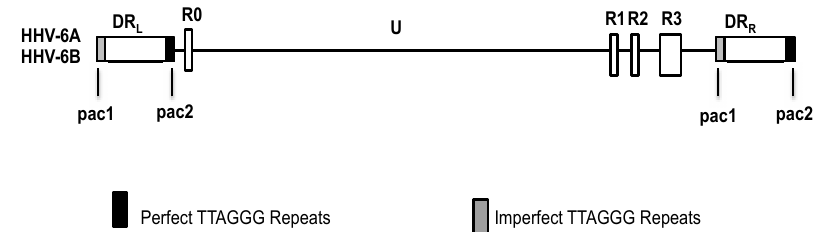
Figure 1. Genome organization of human herpesvirus-6 (HHV-6). Solid lines represent the unique length (U) regions of the genome, boxed regions represent repetitive elements of the genome, and the black boxes represent the perfect telomere repeats, while the gray boxes represent the imperfect telomere repeats. DR L : Direct repeat left; DR R : Direct repeat right; pac1, pac2: Packaging signals; R0–3: Repetitive elements.